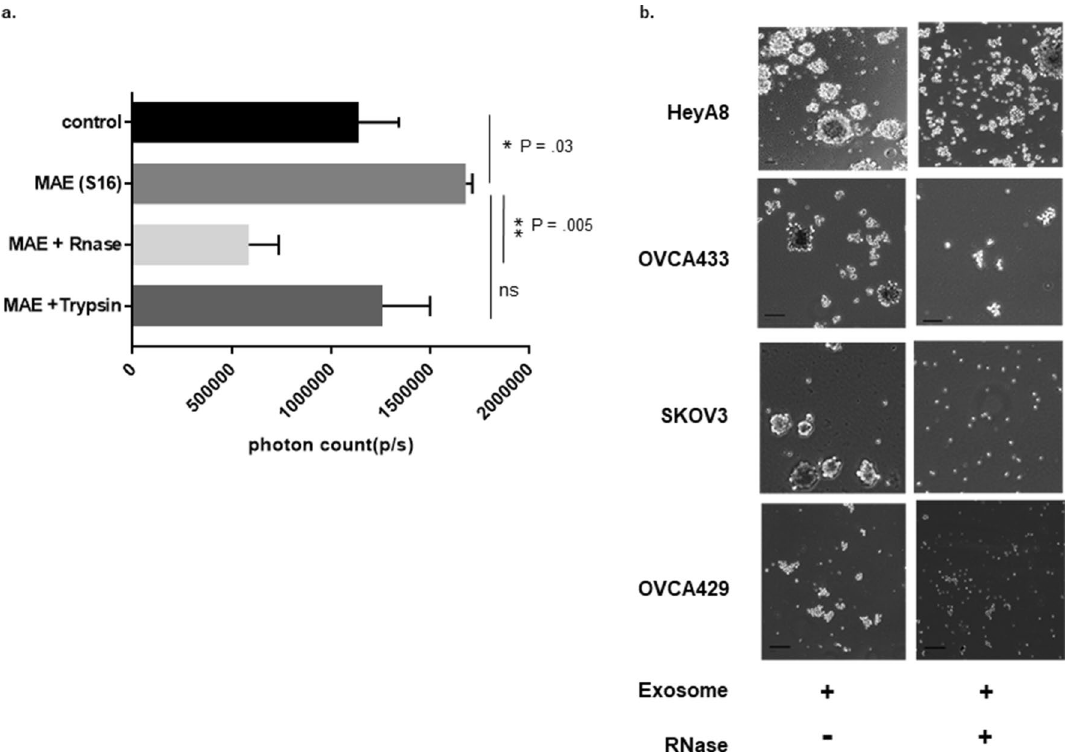
Figure 4. Increased growth of ovarian cancer spheroids is mediated by exosomal miRNA. Ovarian cancer cells HeyA8, SKOV3, OVCA433, or OVCA429, were grown with malignant exosomes treated with RNase along with non-treated malignant exosomes for seven days and assayed for spheroid forming capacities. We found that RNase treatment decreased both size ( b ) and a number of spheroids ( a , b ), indicating a possible role of exosomal